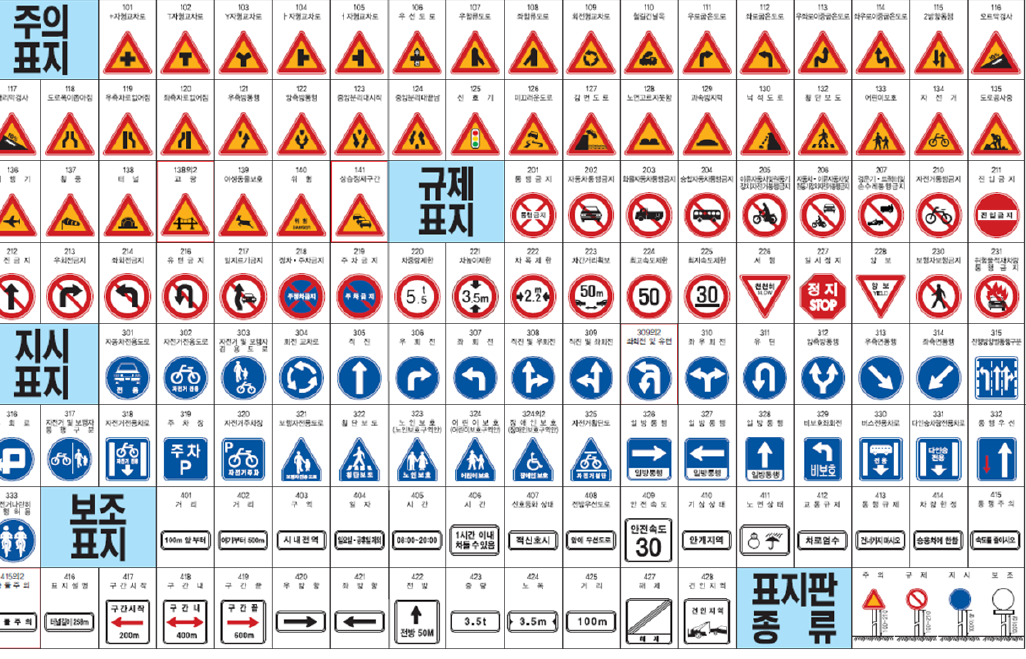
Figure 2. An image of a road sign whose background color is blue ( a ) and the color probability map of the image ( b ) [28].